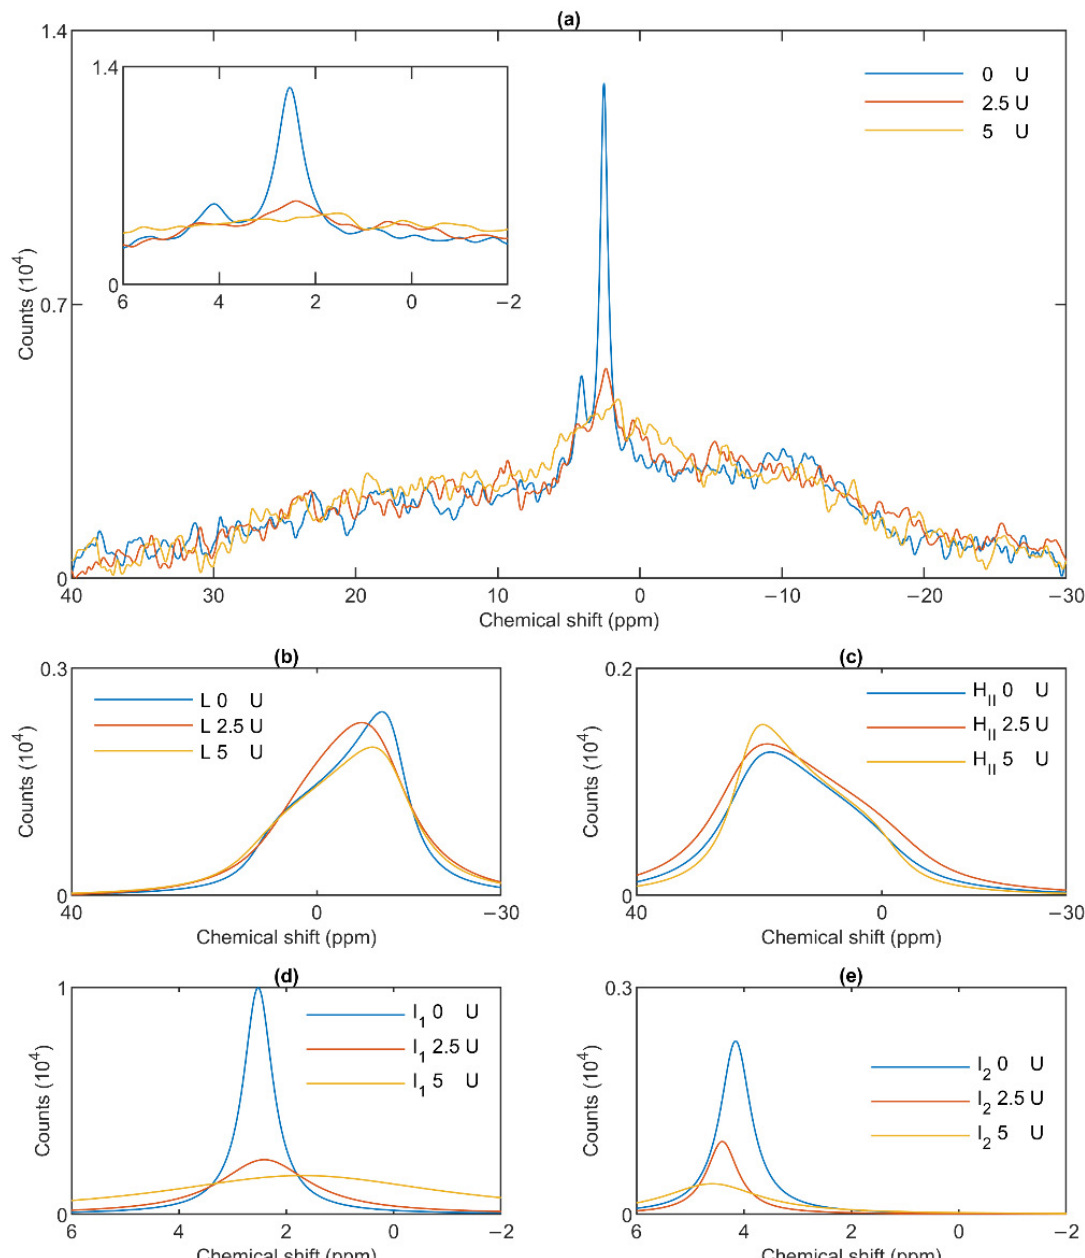
Figure 7. Effects of wheat-germ lipase treatments on the 31 P-NMR spectra of stroma thylakoid membranes ( a ) and on their component spectra: L, the lamellar phase ( b ), H II , the inverted hexagonal phase ( c ), and the two isotropic phases, I 1 ( d ) and I 2 ( e ). The spectra were recorded at 5 °C. The inset in panel a shows the isotropic region.